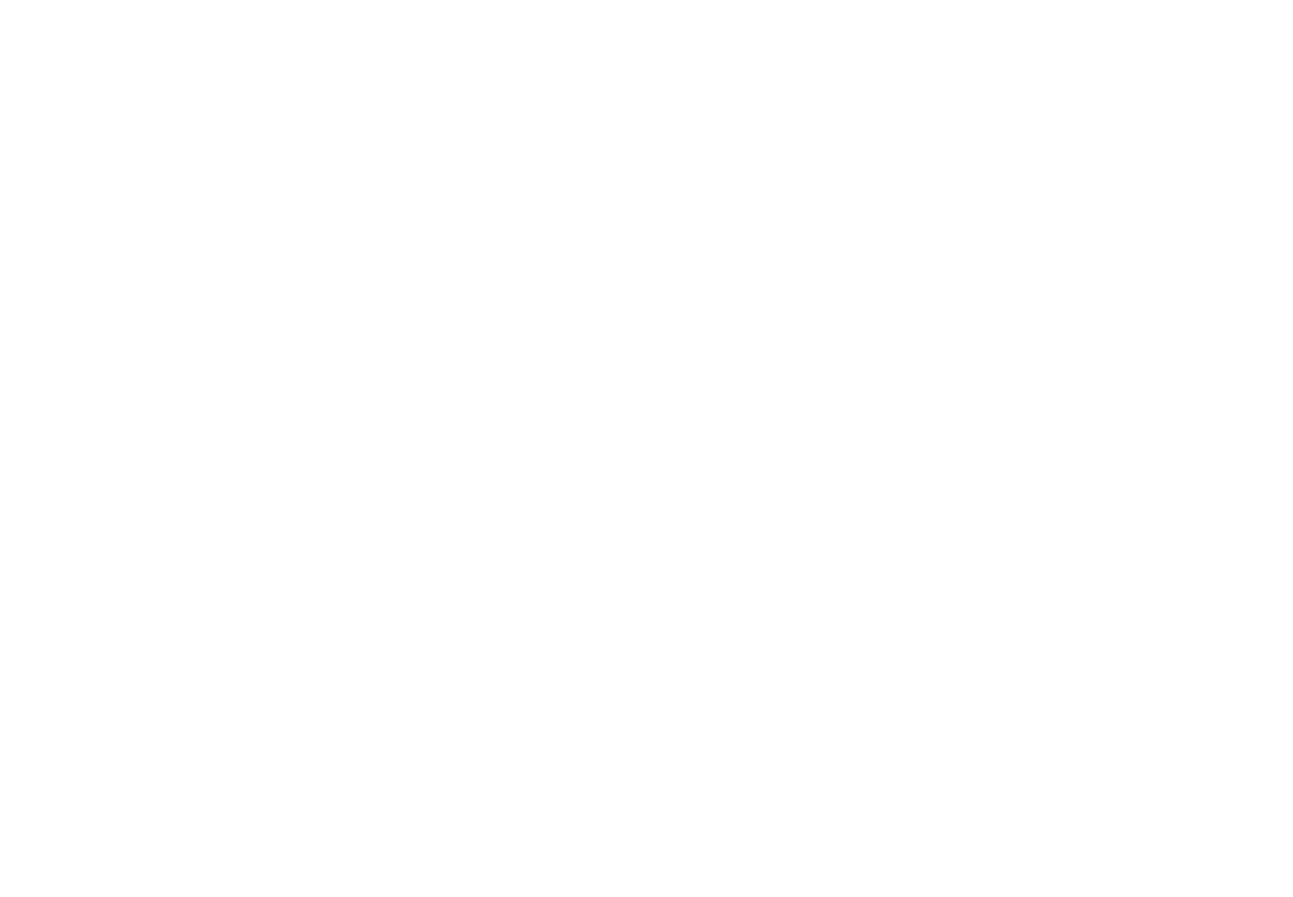
FIGUREA3 | Partial alignment of conserved enhancer region in 20 vertebrate species, approximately − 3800bp of human UCP1. For genome coordinates and full alignment, see